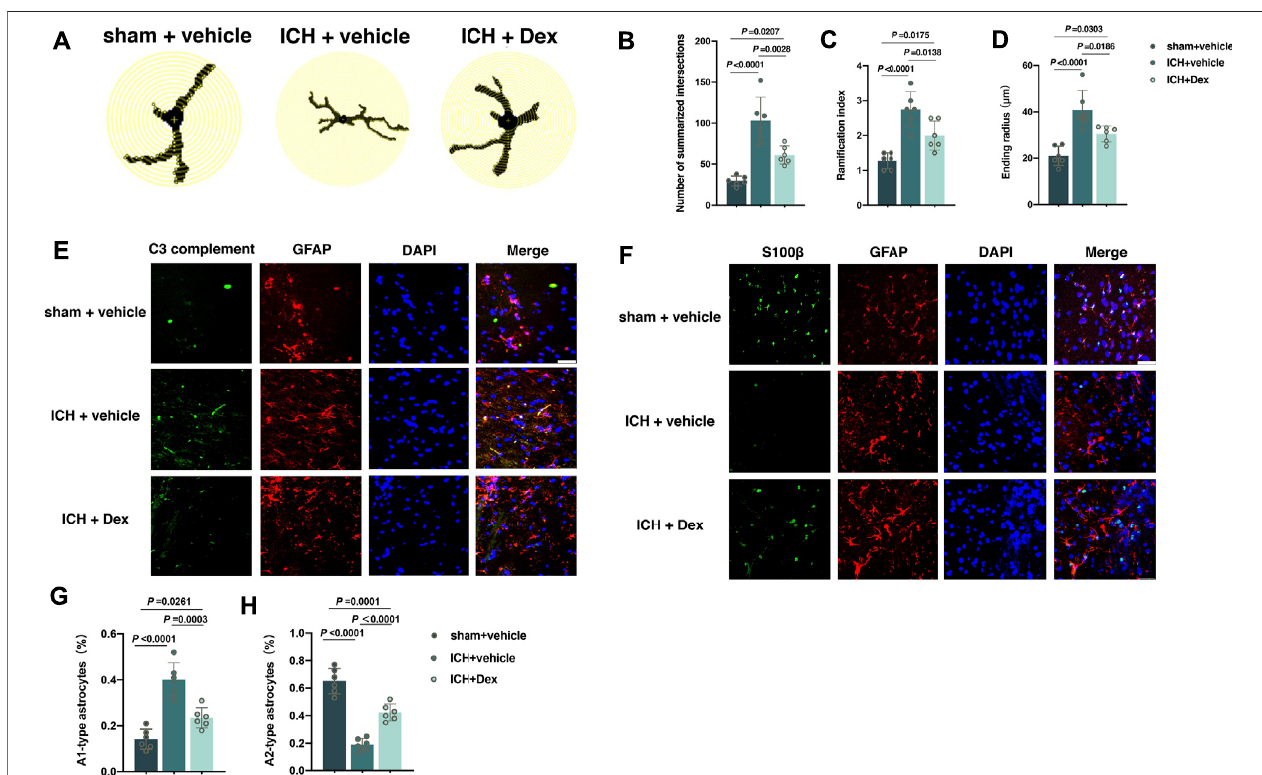
FIGURE 4 | Dexmedetomidine administration attenuated the activation of astrocytes after ICH exposure. (A) Representative detailed Sholl analysis of individual reactiveastrocytesaroundthehematomainthecorpusstriatumcausedbytheindicatedstimuli.Theintervaloftheconcentriccirclesis1 μ m. (B – D) Changesinthesum of intersects, rami fi cation index, and ending radius in the corpus striatum caused by the indicated stimuli. (E) Representative photomicrographs of GFAP and C3 complement plus DAPI staining (GFAP, red; C3 complement, green; DAPI, blue). 200× magni fi cation, scale bar = 50 μ m. (F) The percentage of GFAP combined with C3 complement-positive cells (A1-type) caused by the indicated stimuli. (G) Representative photomicrographs of GFAP and S100 β plus DAPI staining (GFAP, red; S100 β , green; DAPI, blue). 400× magni fi cation, scale bar = 50 μ m. (H) The percentage of GFAP combined with S100 β -positive cells (A2-type) caused by the indicated stimuli. Data are presented as the mean ± SD ( n = 6). Sham, ICH, and Dex are described